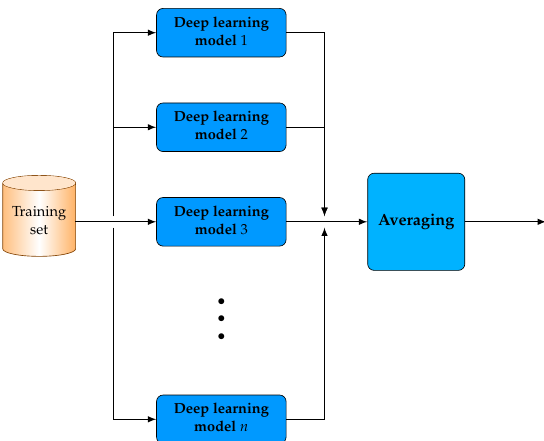
Figure 1. Ensemble-averaging of deep learning models.